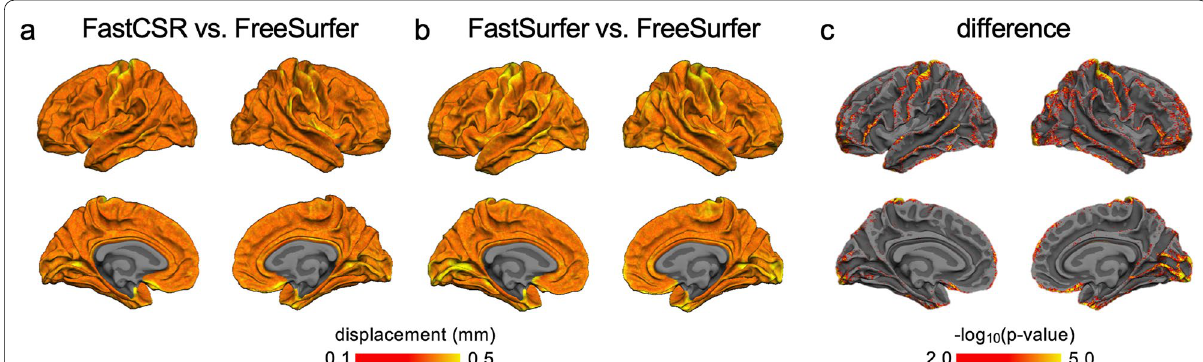
Fig. 4 Differences in surfaces reconstructed by FastCSR, FreeSurfer and FastSurfer. a To quantitatively assess the surface agreement, we measured the average surface displacement between FastCSR and FreeSurfer across participants in the validation set. The maximal displacement between FreeSurfer and FastCSR was smaller than 0.5 mm, which is approximately half of the voxel size. b The average surface displacement between FastSurfer and FreeSurfer was also measured. The average surface displacement map showed a similar pattern with that observed from using the FastCSR method (Spearman’s ρ 0.714, p < 0.0001). c The direct comparison of displacement maps between the FastCSR vs. FreeSurfer contrast and = the FastSurfer vs. FreeSurfer contrast was performed. Results showed that the FastCSR approach achieved overall better performance. Lateral gyri and visual cortices showed significantly smaller displacement in the FastCSR versus FreeSurfer method than FastSurfer versus FreeSurfer (two-tailed paired t -tests, p < 0.01, FDR